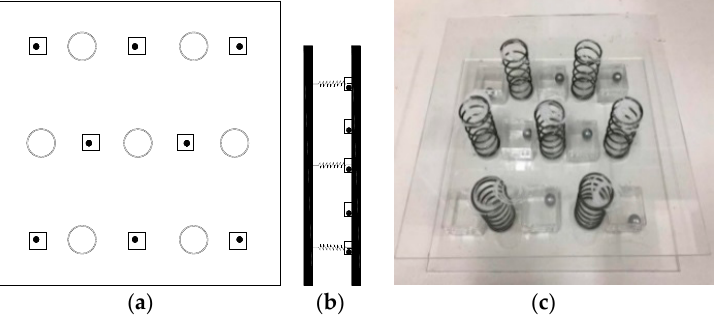
Figure 1. A lateral damping buffer: ( a ) Front view; ( b ) Side view; ( c ) Model picture.